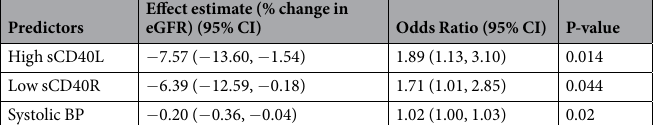
Table 2. Independent Predictors of Percent Change in eGFR at 1-Year Follow-up. Model was adjusted by age, sex, baseline eGFR, systolic blood pressure (SBP), peripheral vascular disease (PVD), diabetes mellitus, primary renal disease, and baseline ACEi/ARB or aspirin use. Odds ratios were calculated for a negative percent change in eGFR at 1-year follow-up. Only significant predictors are shown. Abbreviations: eGFR, estimated glomerular filtration rate; sCD40L, soluble CD40 ligand; sCD40R, soluble CD40 receptor; BP, blood pressure; and CI, confidence interval.